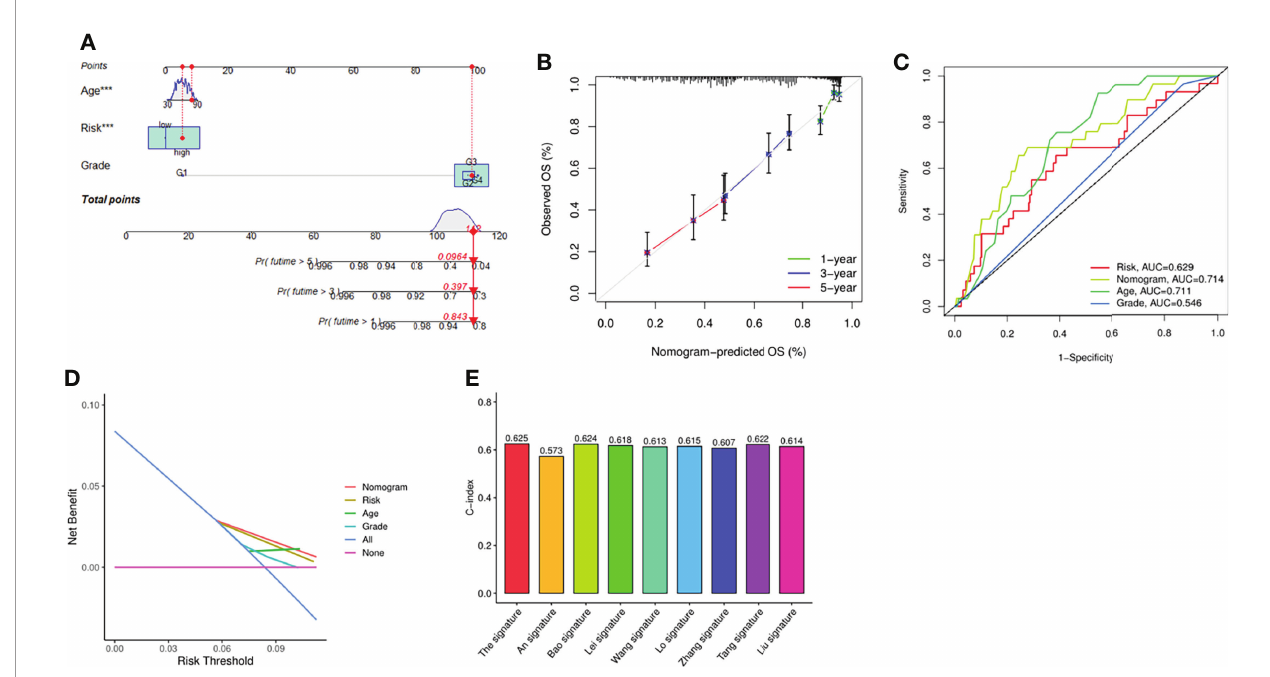
FIGURE 4 | Evaluation of the risk signature. (A) Nomogram of the model integrated by the risk score and clinical parameters. (B) Calibration curve of the model. (C) ROC analysis of the nomogram and clinical features. (D) DCA curve based on the risk score and the clinical parameters. (E) Comparison between the signature and other established model. *** P <